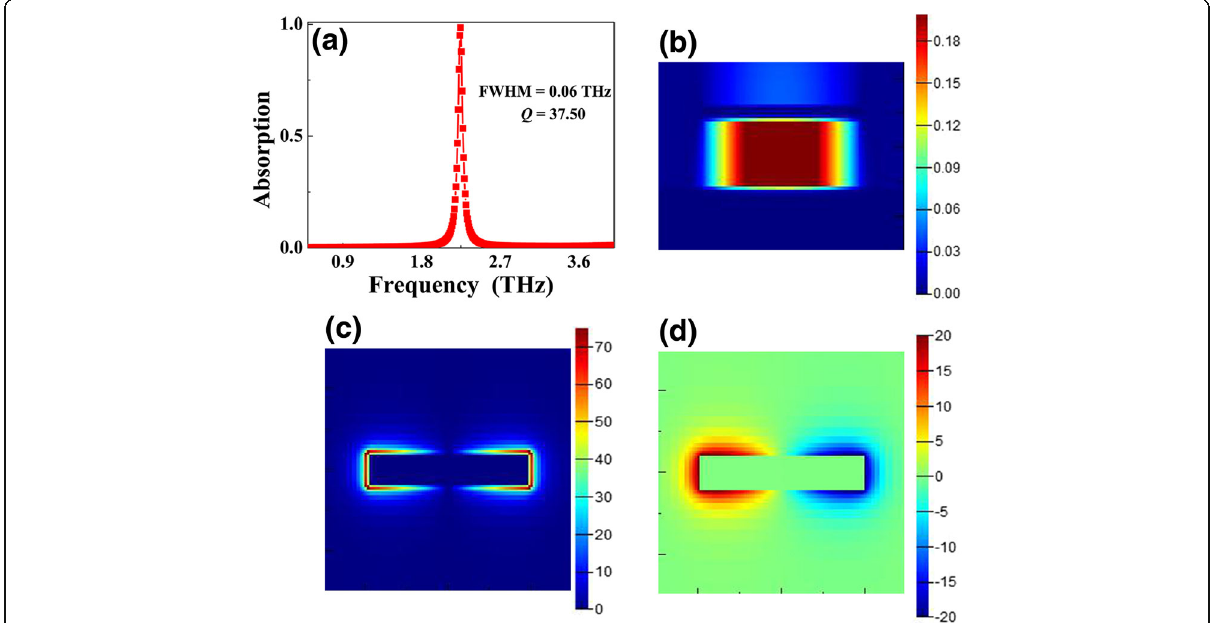
Fig. 2 Absorption curve of the single-band MPA under plane wave irradiation is provided in a ; b , c , and d give the field distributions of the | H y|, | E |, and E z at a peak of 2.25 THz,